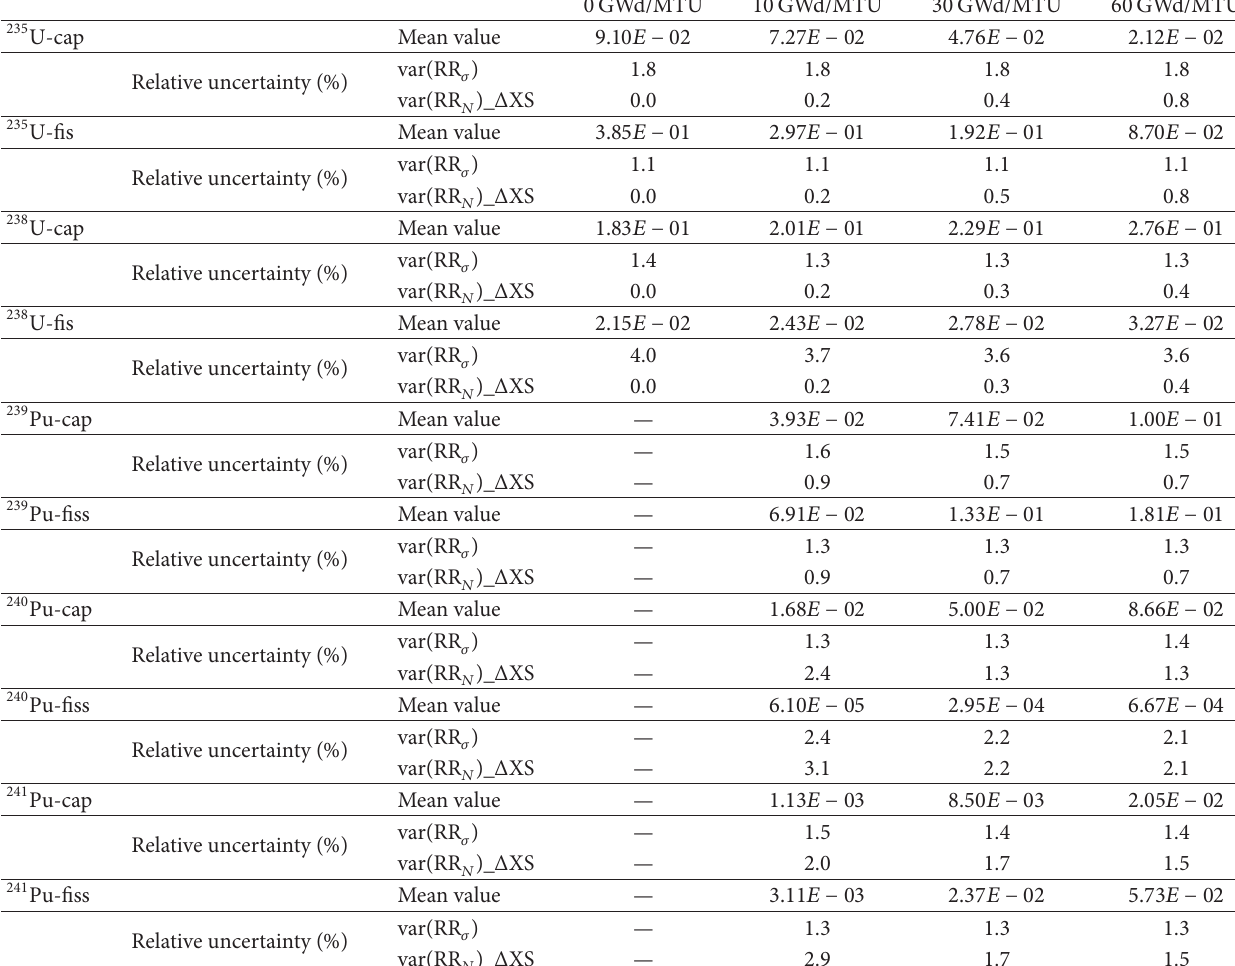
T 8: Uncertainty in reaction rates. Cross-section uncertainties are taken from